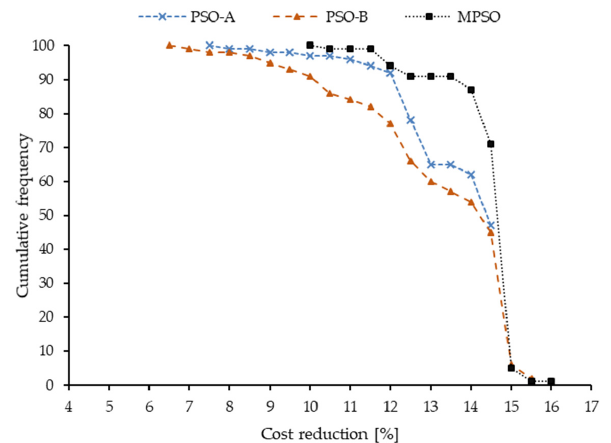
Figure 8. Performance comparison of standard particle swarm optimization (PSO) and modified PSO (MPSO).